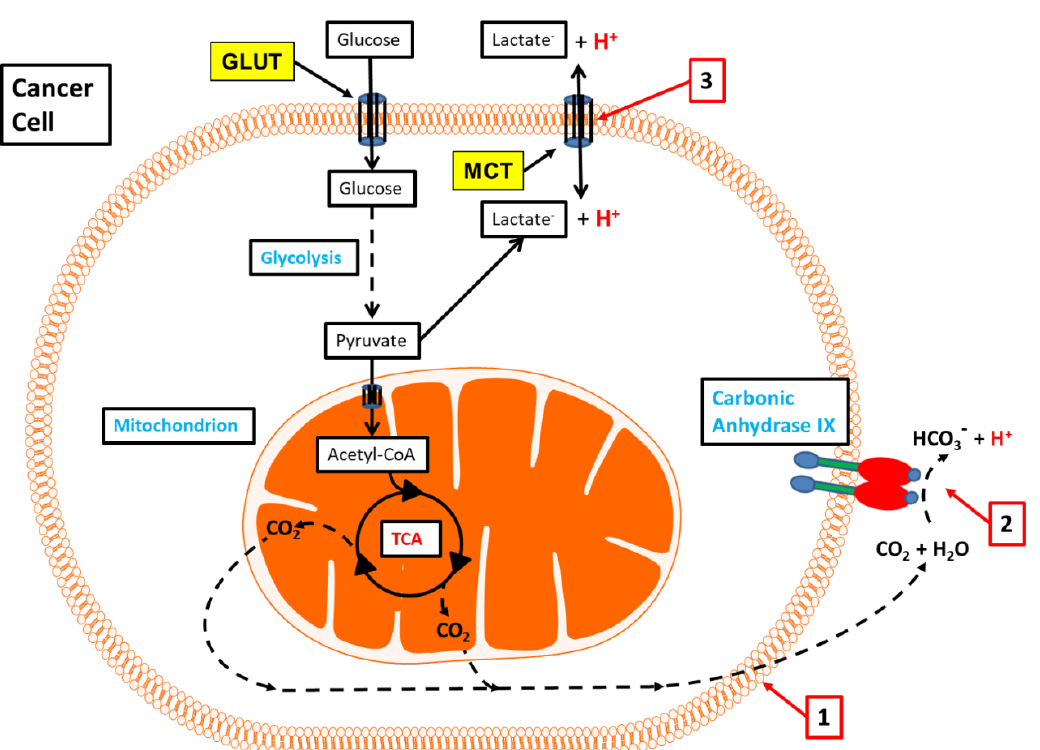
Figure 1. Carbonic anhydrase IX (CAIX) links tumour energy metabolism to its pH regulation. 1. The major by-product of oxidative energy metabolism, CO 2 diffuses across the cell membrane lipid bilayer into the extracellular space, along its concentration gradient; 2. On the extracellular surface of the cell membrane, the exofacial catalytic domain of CAIX catalyses the hydration of CO 2 to form H + and HCO 3 − ; 3. In parallel, lactate, the end-product of glycolysis, exits the cell through the monocarboxylate transporter at a rate that is influenced by the pH gradient across the cell membrane (pH i – pH e gradient). GLUT, glucose transporter; MCT, monocarboxylate transporter.